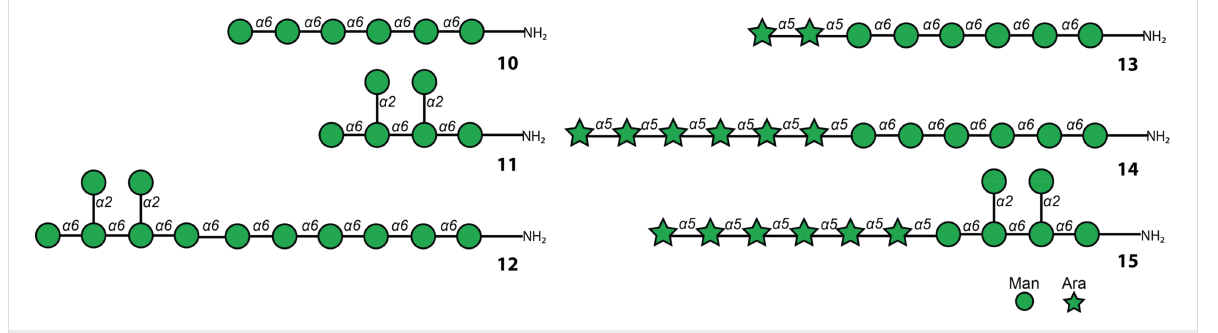
Figure 2: Schematic representation of LAM and AM oligomers obtained using AGA.